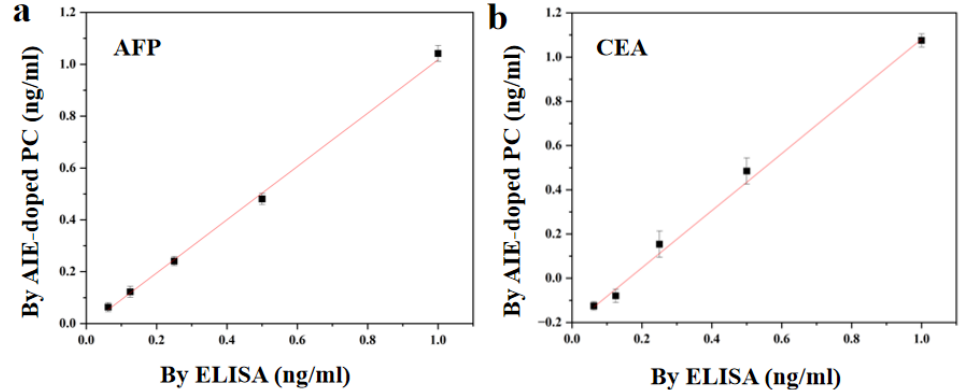
Figure 6. Correlation between multiplex bioassay based on AIEgens-doped PCs and ELISA for the determination of ( a ) AFP and ( b ) CEA in pbs samples. Any sample was repeated three times. The error line represents the standard deviation.